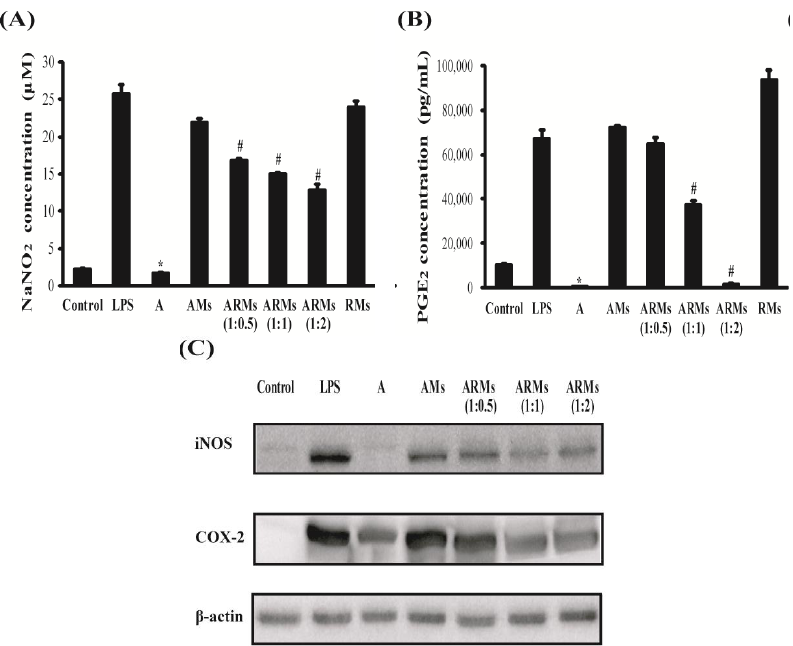
Figure 2. Effects of ARMs on LPS-stimulated NO and PGE 2 production, and iNOS and COX-2 expressions in RAW264.7 cells. The samples of hepatic metabolites were made as described in the Materials and Methods section. Cells were treated with the standard concentration (A; 20 µ M) and hepatic metabolites of apigenin (AMs; 20 µ M), hepatic metabolites of apigenin (20 µ M) and